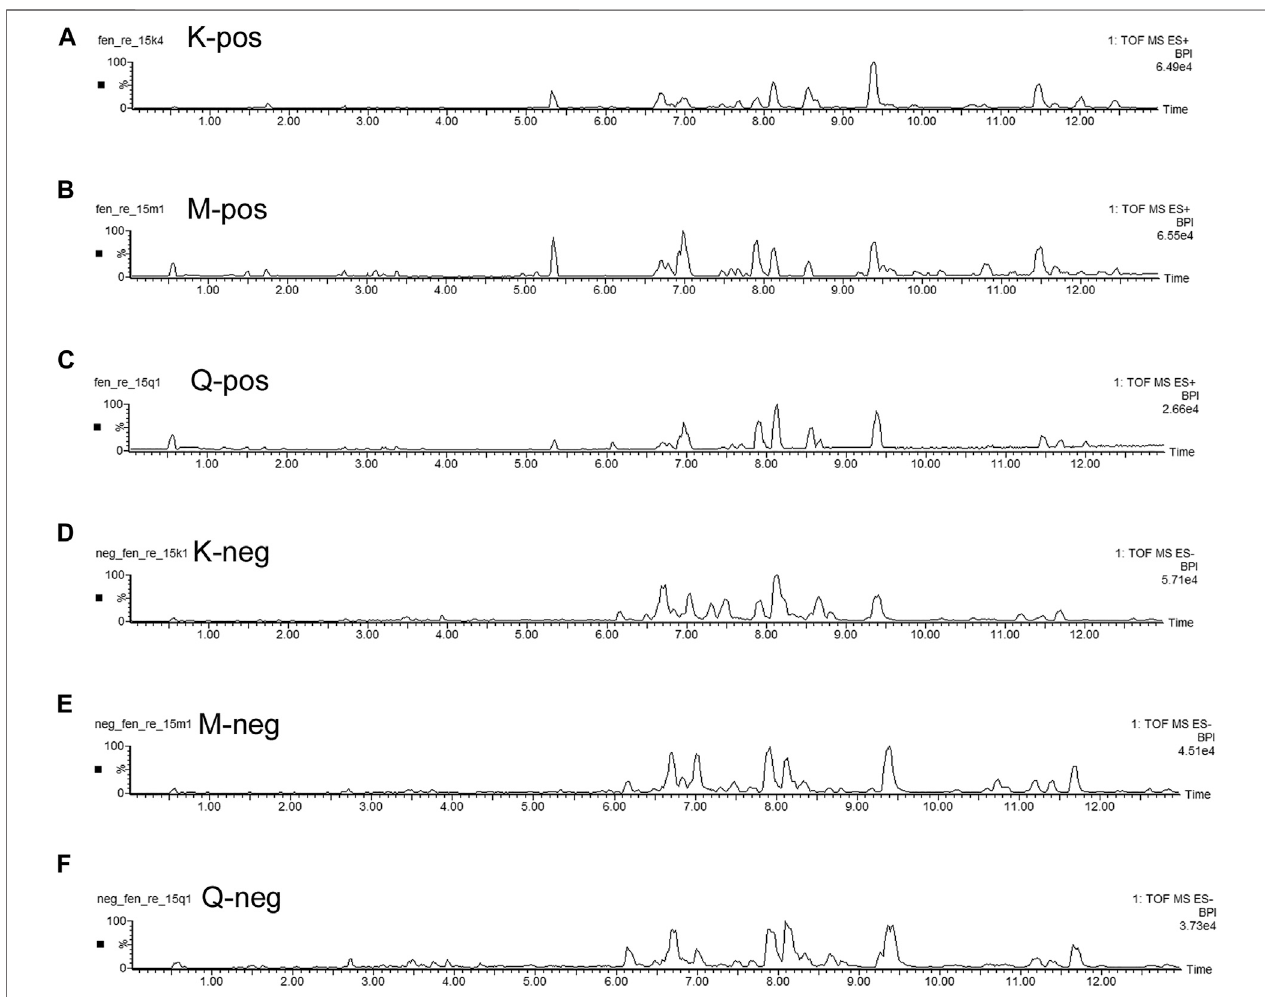
FIGURE1| BPIchromatogramsofthe R.Scrophulariae extract, model and controlgroups.K representstheControlgroup, M represents the Modelgroup, and Q represents the R. Scrophulariae group.